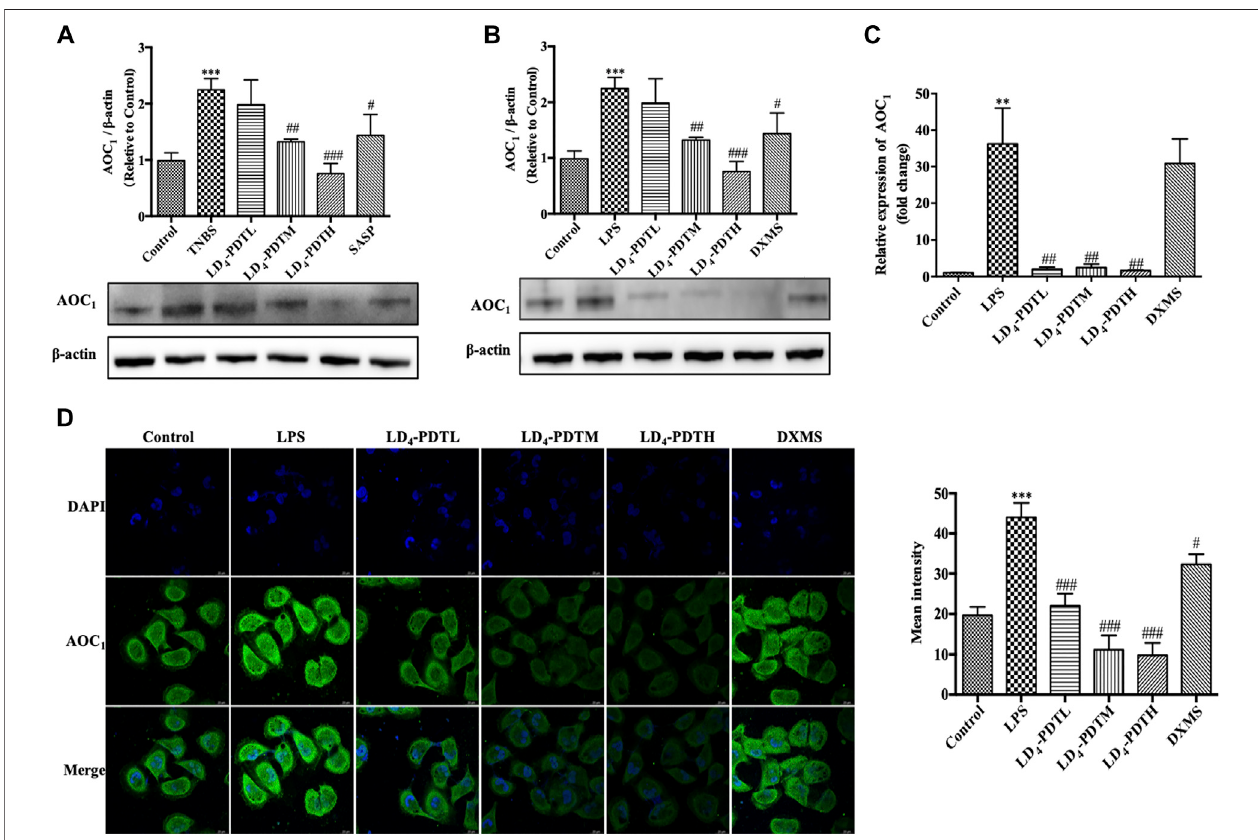
FIGURE5| LD 4 -PDTsuppressedtheexpressionof AOC 1 . (A,B) Proteinexpressionof AOC 1 incolontissueandinHCoEpiCcellsweredeterminedbywesternblot analysis. (C) Gene expression of AOC 1 in HCoEpiC cells was examined by qRT-PCR. (D) Protein expression of AOC 1 was detected by immuno fl uorescence. Bars, 20 μ m** p < 0.01 ,*** p < 0.001 vs controlgroup; # p < 0.05 , ## p < 0.01 , ### p < 0.001 vsTNBS modelgroup. Datawererepresentativeofthreeindependent experiments, expressed as mean ±